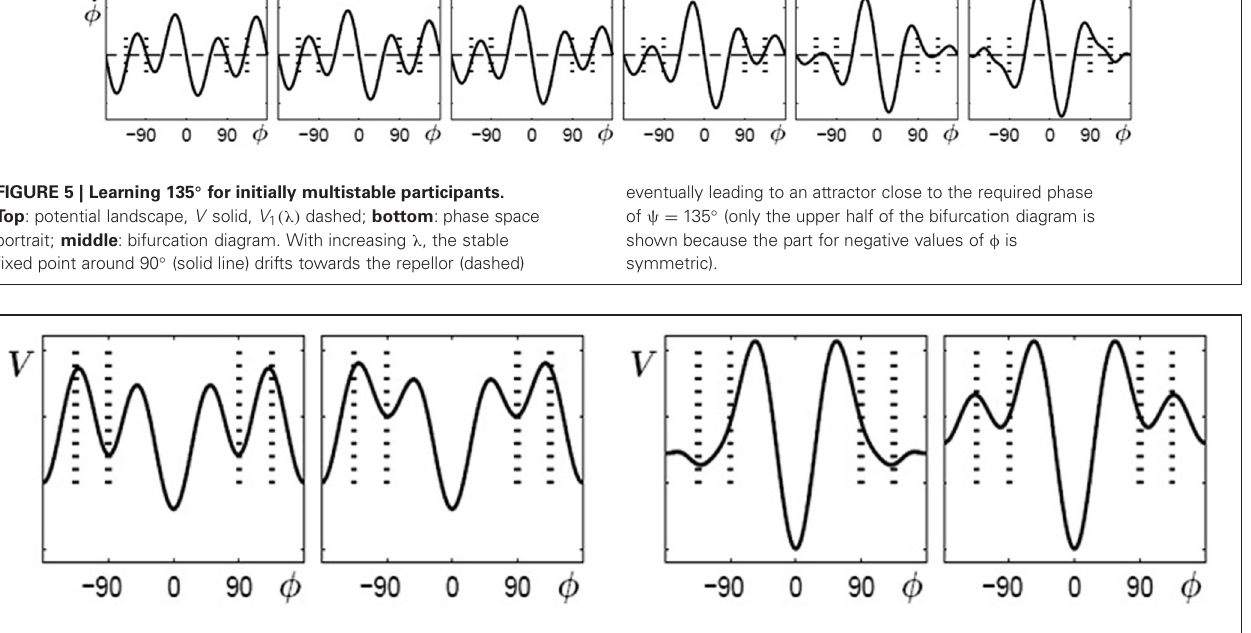
(left) persist (right). Right part : multistable participants where the minima located at ± 135 ◦ after learning (left) shift back close to their initial values at ± 90 ◦